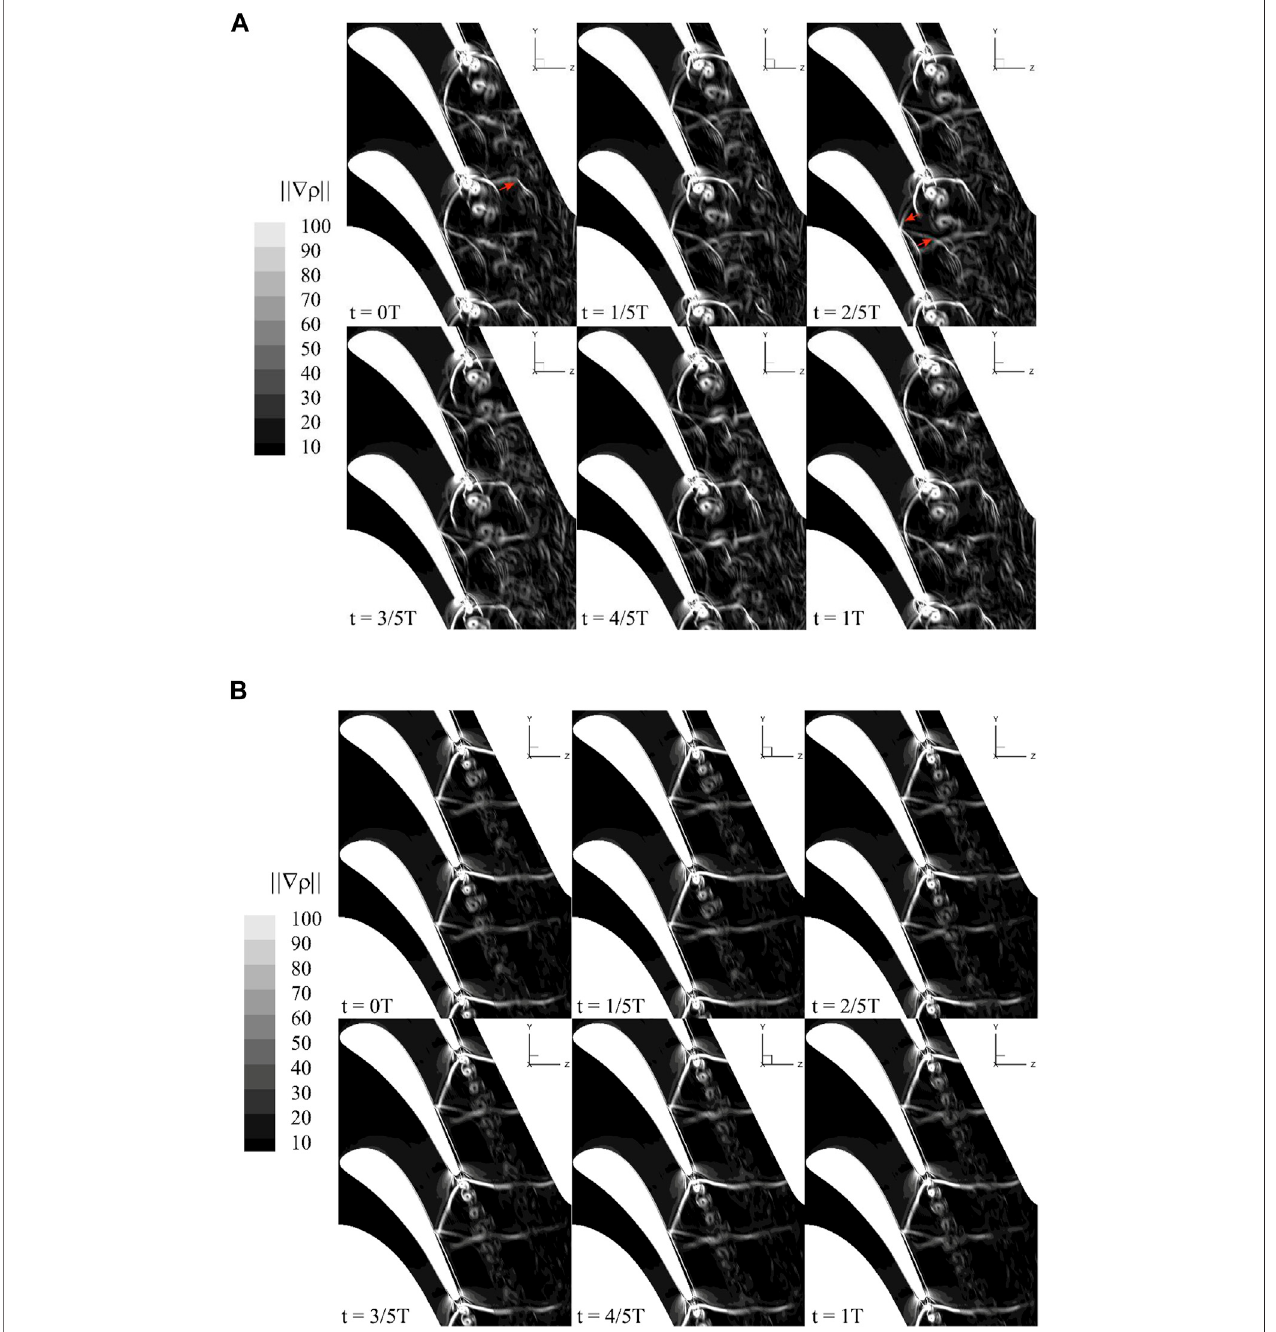
FIGURE 15 | Numerical Schlieren of prototype and BTE at different times when Ma (cid:1) 1.1. (A) Prototype (B) Biomimetic.